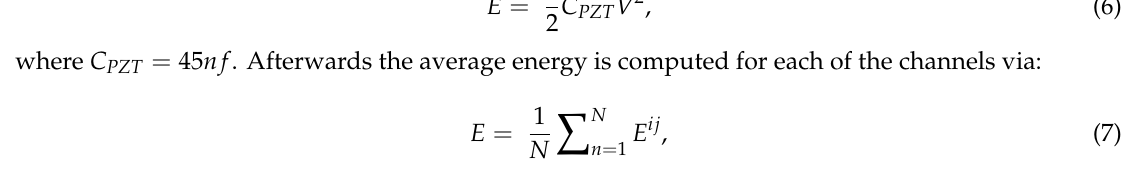
Table 2. Results of CNN on the individual HI and SI from different heights.